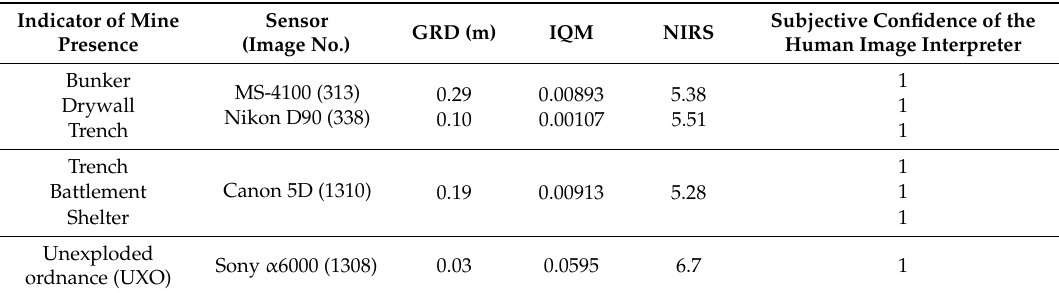
Table3. Someexamplesofradiometriccharacteristics, theoreticalGSDofselectedimageswithindicators of mine presence, cameras with which the images were collected and the subjective confidence of the human image interpreter in his